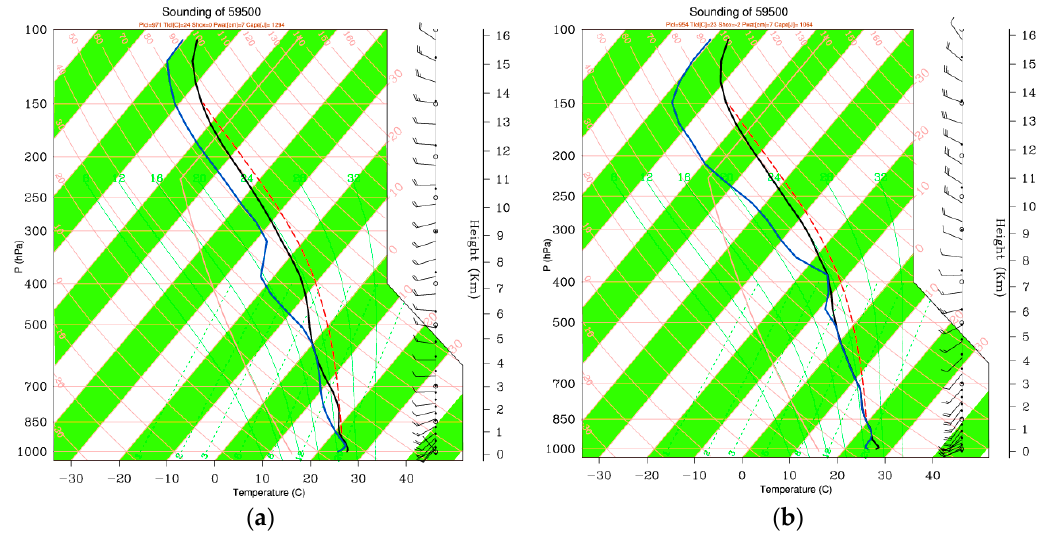
Figure 11. As in Figure 10 but showing the simulated results for Haifeng At ( a ) 1200 UTC on 19 May and ( b ) 0000 UTC on 20 May.